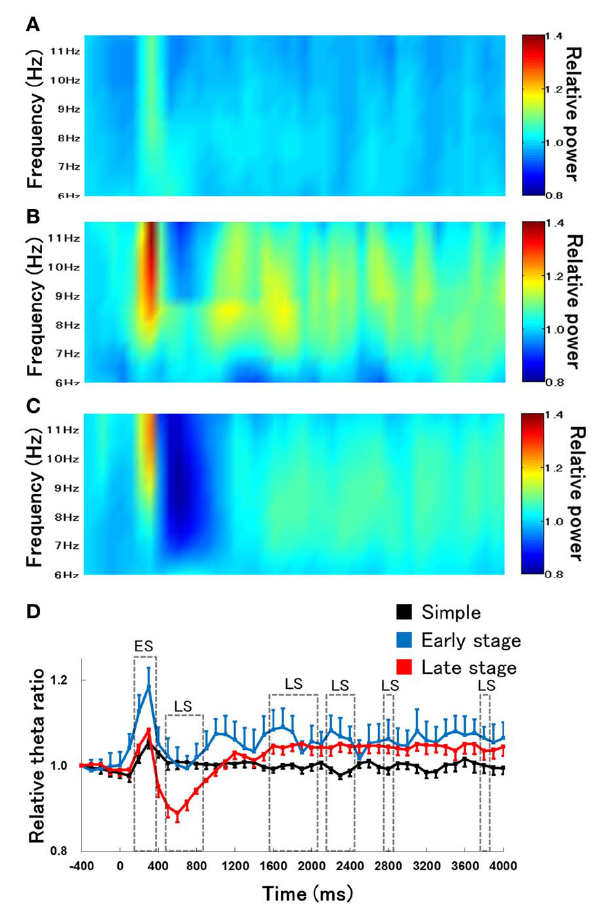
FIGURE 4 | The relative change in hippocampal theta power during RFTs during the retention test for the simple discrimination task (A), the early learning stage (B), and late learning stage (C) of the FN task. The 0-ms period indicates the onset of stimulus presentation. The x-axis represents time (ms), and the y-axis represents frequency (Hz) in panels (A–C) . The period was divided into 45 sub-periods of 100ms each. The mean hippocampal theta power from 500 to 400ms before stimulus onset was counted as the − 400-ms period (no stimuli were present and no rats pressed the lever during this period), and the relative theta power calculated for each period was normalized to that of the − 400-ms period (relative theta power of each period = theta power of each period/theta power at the − 400-ms period). Panel (D) depicts the mean hippocampal theta power between 6 and 12Hz (Simple: simple discrimination task; Early stage: early learning stage of the FN task; Late stage: late learning stage of the FN task). The “ES” indicates a significant difference between the early learning stage of the FN task and the retention test for the simple discrimination task (ES: p < 0 . 05 ), the “EL” indicates a significant difference between the early learning stage and the late learning stage of the FN task (EL: p < 0 . 05 ), and the “LS” indicates a significant difference between the late learning stage of the FN task and the retention test for the simple discrimination task (LS: p < 0 . 05 ). Error bars indicate s.e.m.